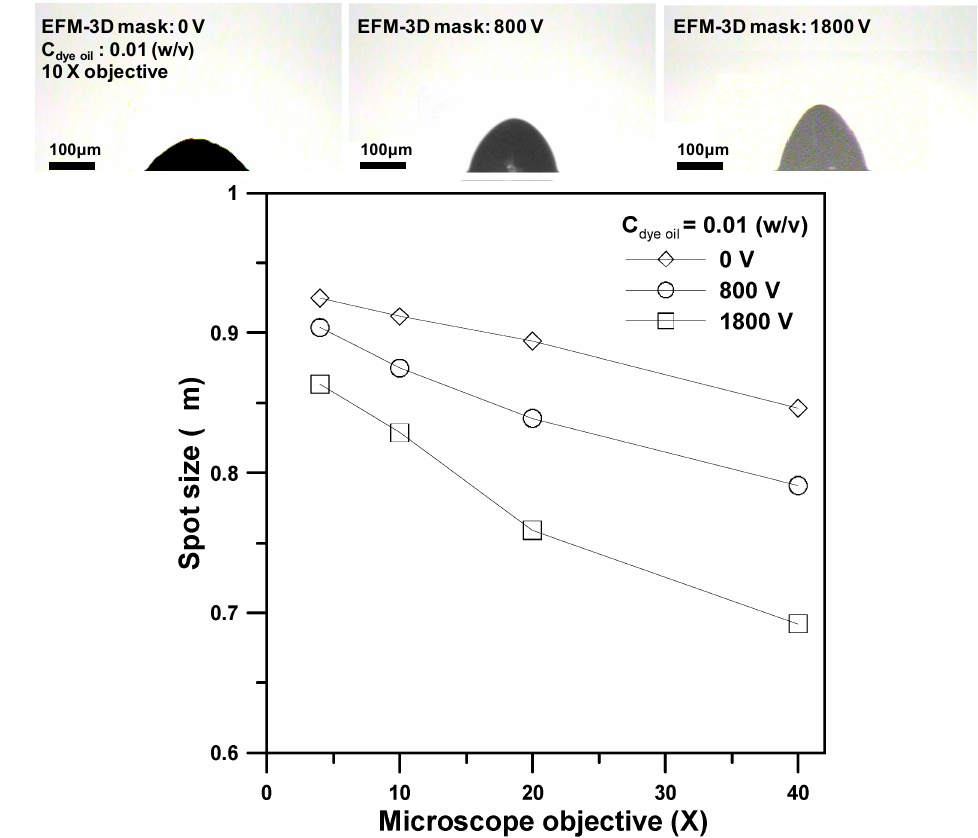
Figure 8. ( a ) Images of the photopolymerized microlens structures produced by utilizing 10× objective for the EFM-3D mask filled with the dye oil at C dye oil = 0.01 ( w / v ) and operated at 0 V, 800 V, and 1800 V, respectively. ( b ) The focus spot size of the produced microlens structures with respect to the objective magnifications from 4× to 40× at C dye oil = 0.01 ( w / v ) and operated at 0 V, 800 V, and 1800 V,